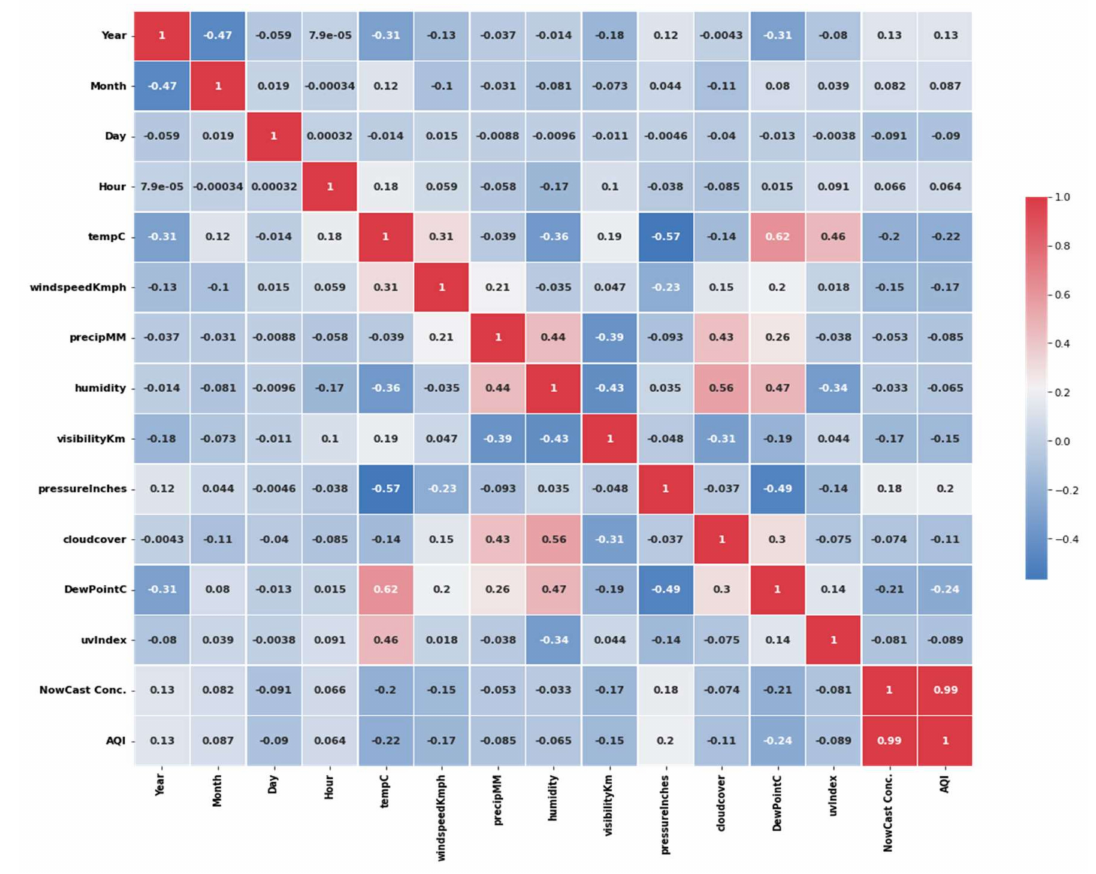
Figure 15. Correlation heat map for Islamabad.